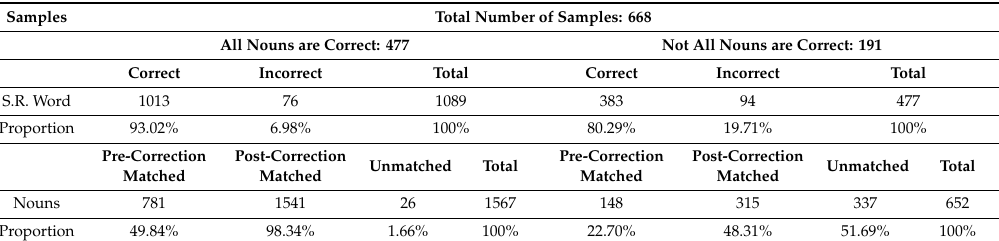
Table 7. The results of the overall analysis of the